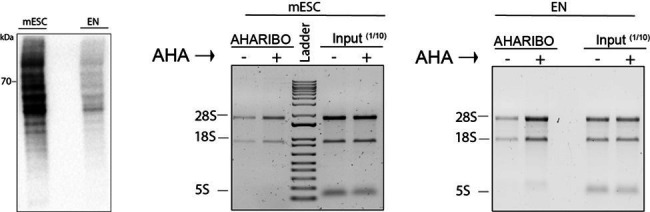
Total protein staining.Left, total proteins from mESC and early neurons (EN) cell lysates (20 µg total protein for each sample measured by Bradford assay) loaded on a SDS-PAGE and the membrane stained by biotin-cycloaddition followed by streptavidin-HRP. Central and right panel, agarose gel electrophoresis of total RNA extracted from input lysates (1/10 of the total lysate volume) and lysates subjected to AHARIBO pulldown from mESC (left) or EN cells (right) either treated (+) or not (-) treated with AHA.